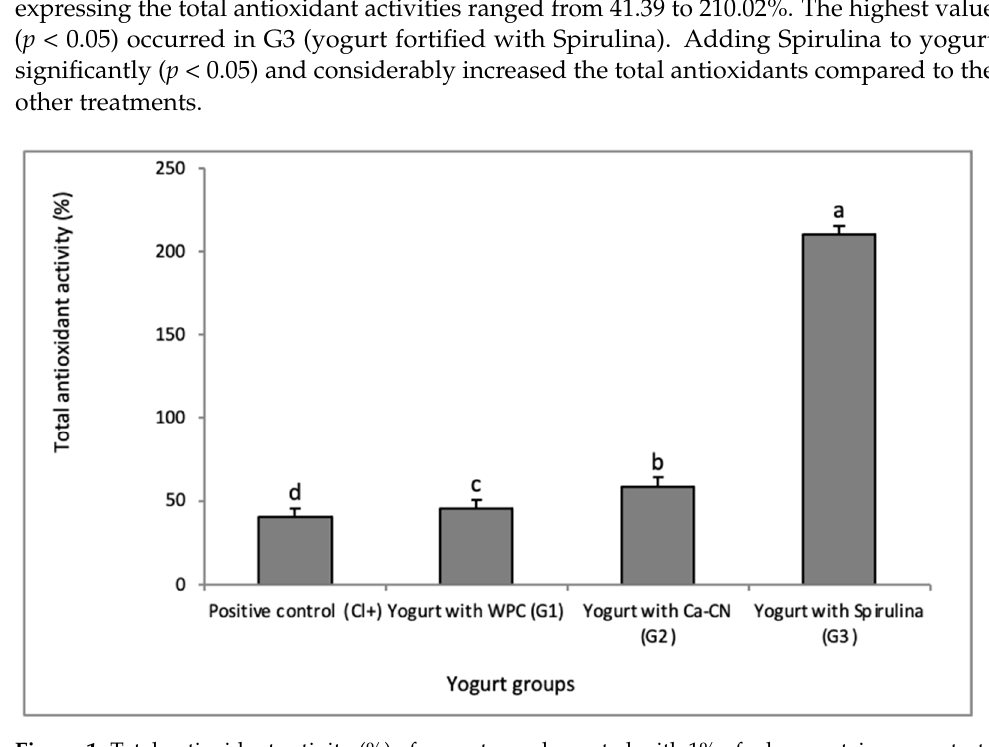
Figure 1. Total antioxidant activity (%) of yogurt supplemented with 1% of whey protein concentrate (G1), calcium caseinate (G2) and Spirulina powder (G3) as compared to a positive control (Cl+; yogurt without additives). Different letters (a, b, c, and d) within a column mark significantly different value ( p < 0.05 ).